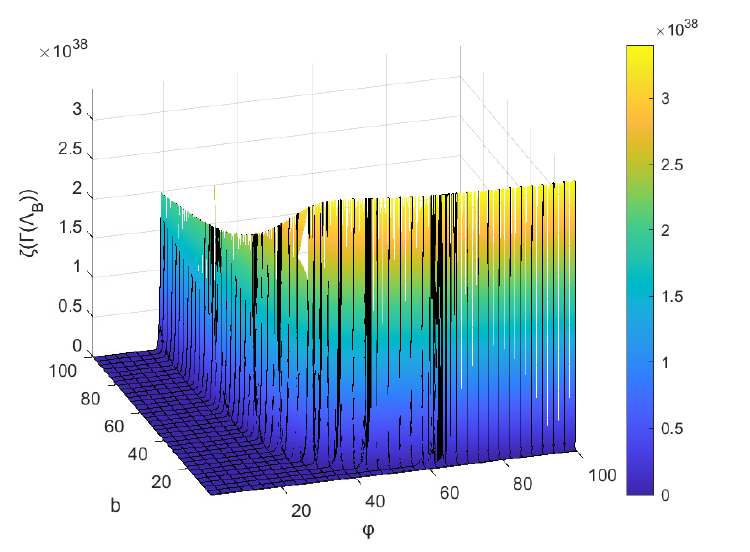
Figure 5. Total eccentricity index of Γ ( Λ (cid:66) )